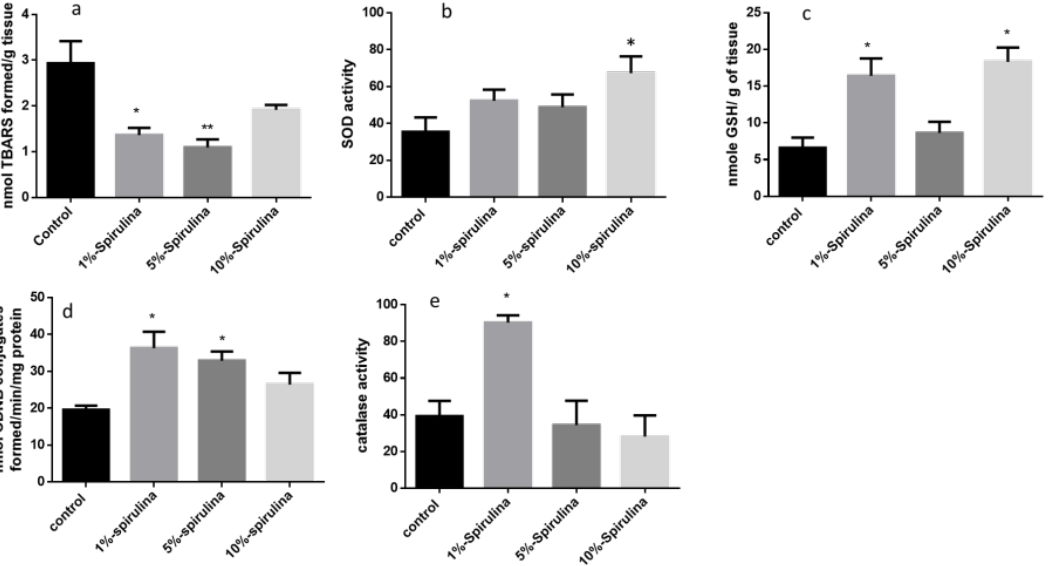
Figure 2. Hepatic antioxidant activity of grass carp fed with 0,1,5 and 10% Spirulina for 90 days. Data expressed as mean ± S.E.M *—represent significant difference p < 0.05. **—represent statistical differences of p < 0.01. ( a ) Lipid peroxidation is expressed as nmol of thiobarbituric acid reactive substance (TBARS) formed. ( b ) Superoxide dismutase activity. ( c ) Reduced glutathione level. ( d ). Glutathione-S-transferase activity is expressed as nmol of 1-chloro-2,4-dinitrobenzene (CDNB)